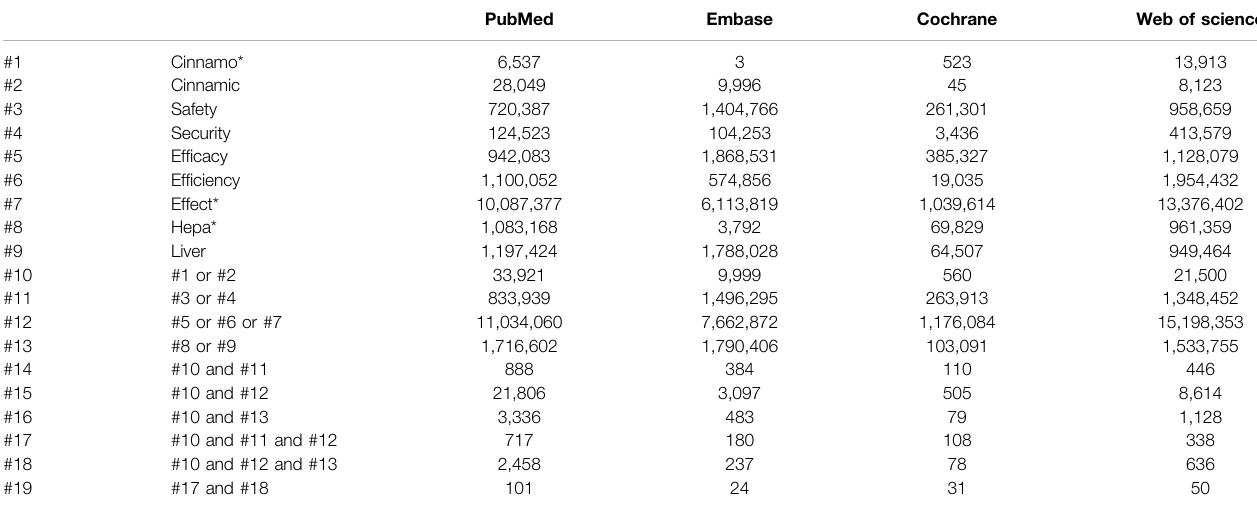
TABLE 1 | Search strategy until August 10,